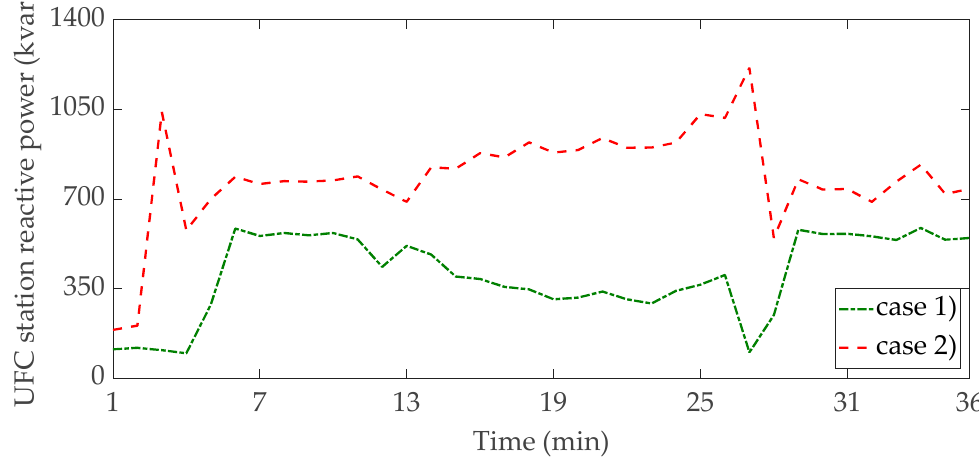
Figure 12. Reactive power profile of the UFCS 3 located at bus #12 in the three case studies.